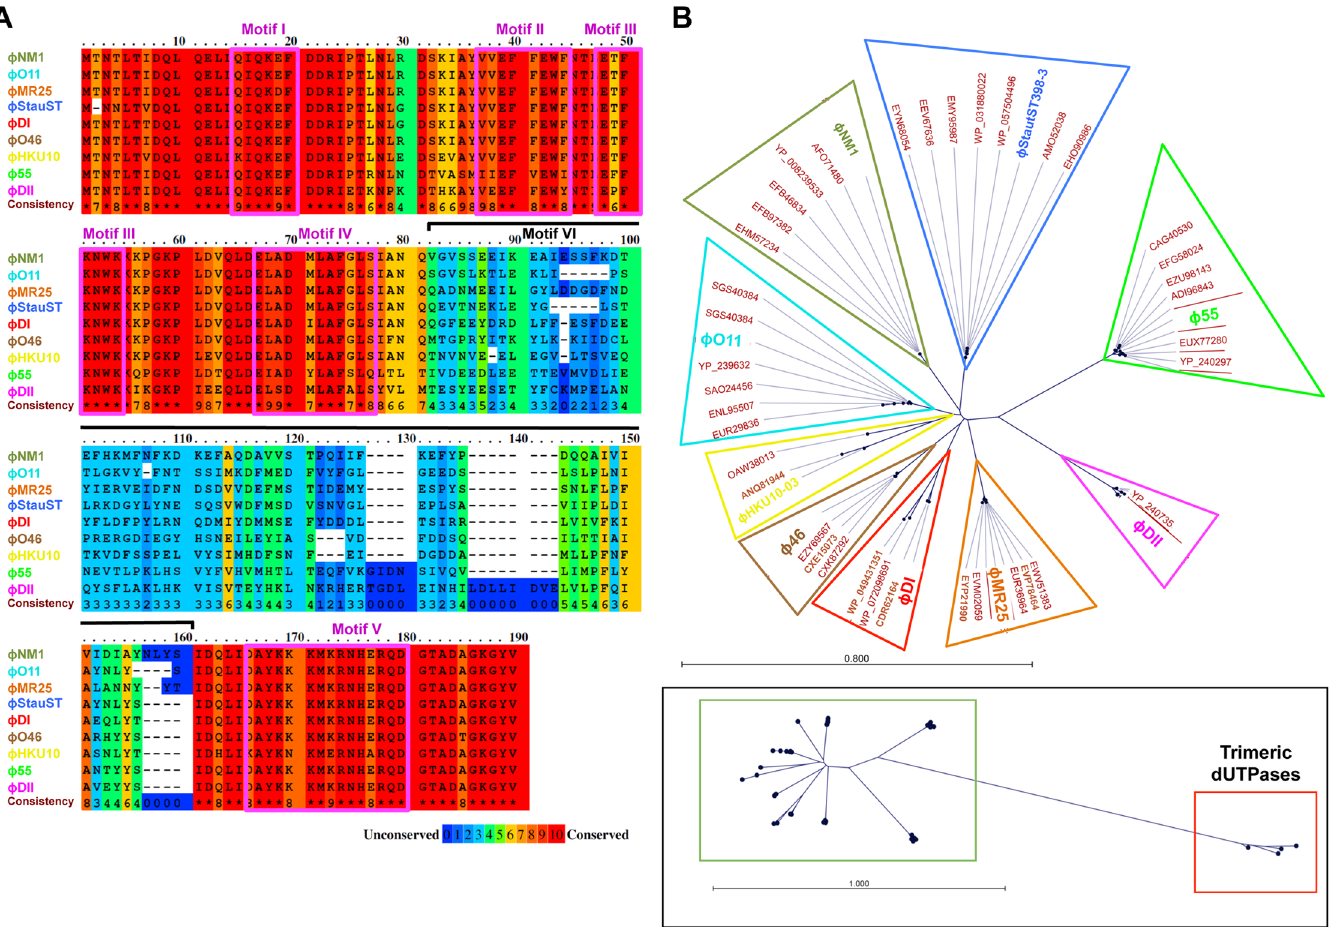
Fig 1. S . aureus phage coded dimeric Duts show allelic variation. (A) Alignmentof dimeric Duts from S . aureus phages ϕ NM1, ϕ DI, ϕ DII, ϕ O11, ϕ O46, ϕ MR25, ϕ StauST398-3 (StauST), ϕ HKU10-03 (HKU10) and ϕ 55 are shown representingthe nine different dimeric Dut families identifiedin the phylogenetic tree describedbelow(Fig 1B). Coloursindicate relative sequenceconservation at each position,with red beingmost conservedand blue being least (alignmentgeneratedby PRALINE). The five conservedcatalytic motifs in dimeric Duts are highlightedin magentaboxes and labeled. The bracket indicates the localization of the extra motif VI. (B) Radial phylogenetic tree of identified staphylococcal and Staphylococcus phage dimeric Duts. Radialtree showing the 9 different groups, constructed using the alignmentof protein sequencesof the dimeric Duts from staphylococcal phages(includingthe full sequence,not just the variableregion)listed in S1 Table. An NCBI BLAST of the known SaPI inducing ϕ NM1phage encodeddimeric Dut (full sequence)was used to select 59 dimeric Dut sequencesthat were annotated as staphylococcal phage Duts or as staphylococca l Duts. S . aureus does not encodea genomicDut so any such annotations wouldalso be phagic.Four trimeric staphylococca l phage Duts were also includedin the alignment and tree to provide outliersand show the distanceof these proteins from the dimeric Duts. The accessionnumbers for all sequencesare listed in S1 Table. The small box belowshows the full tree, includingthe trimeric Dut outliers (red box), which were hiddenfor clarity in the more detailed tree above. This detailedtree consists of the area highlightedwith the green box in the full depiction. Groups are shown by clusteredleaf node names and the name of the representativeused in the sequence alignmentof panel (A) is highlightedwith the same colour of the group. The tree was created using the followingparameters; algorithm= Neighbour Joining, distancemeasure = Jukes-Cantor, bootstrap = 100 Replicates. Proteins are namedby NCBI accession number with the exceptionof the group representativewhere the name of the corresponding phage is includedused (S1